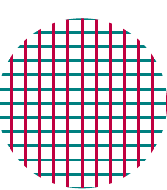
Figure A.9: In the neighbourhood of any regular point of Σ , the horizontal and ver- tical trajectories form a rectangular grid like in (cid:67) . lines of the real axis